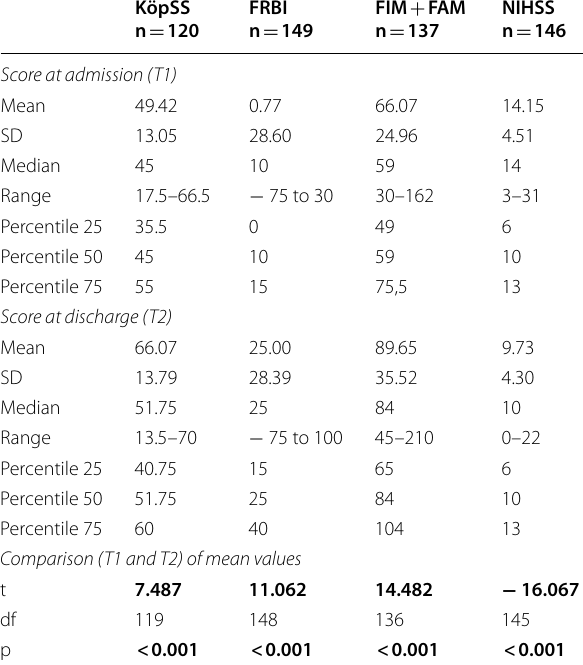
Table 2 Improvement in the cognitive and functional outcome scales during the early rehabilitation and distribution characteristics